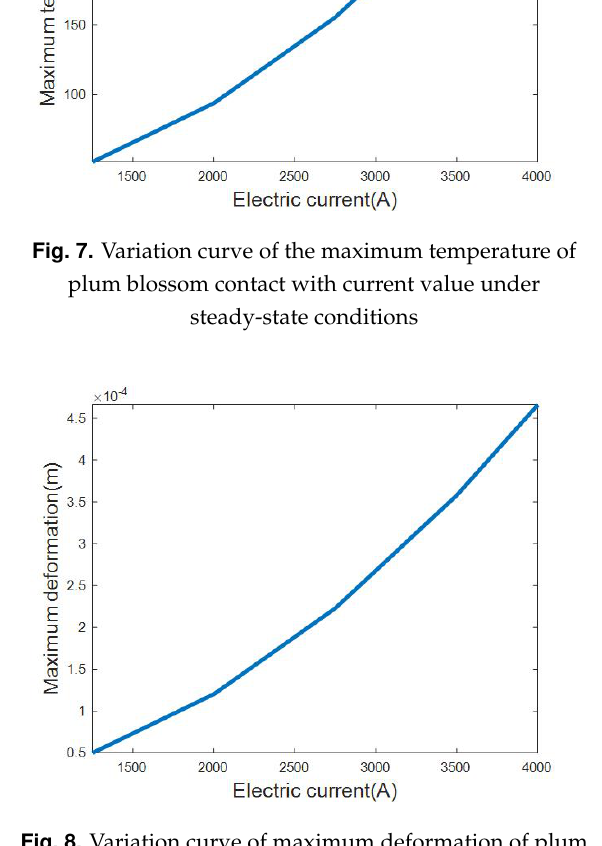
Fig. 8. Variation curve of maximum deformation of plum blossom contact with current value under steady-state